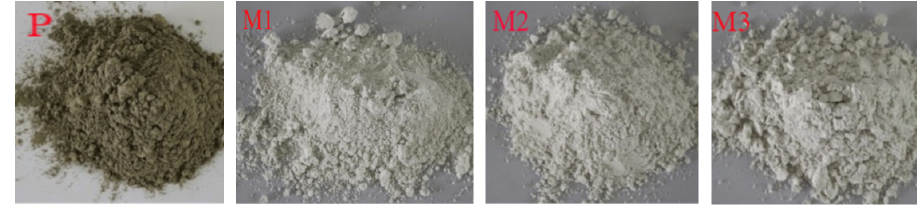
Figure 1. Raw material test samples.